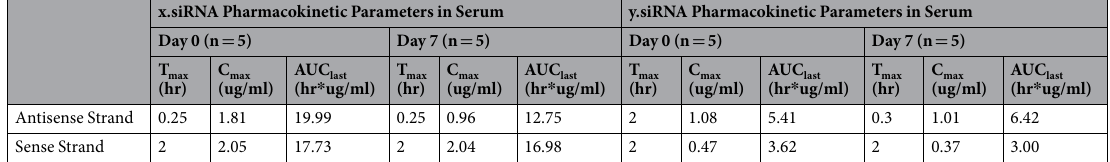
Table 4. Pharmacokinetic parameters of x.siRNA and y.siRNA antisense and sense strands in Sprague Dawley rat serum shown as Mean (SD). T max = time of maximum concentration; AUC last = area under the concentration time-curve from time 0 to last measurable concentration. All values are reported to 3 significant digits, with the exception of T max , which is reported as median